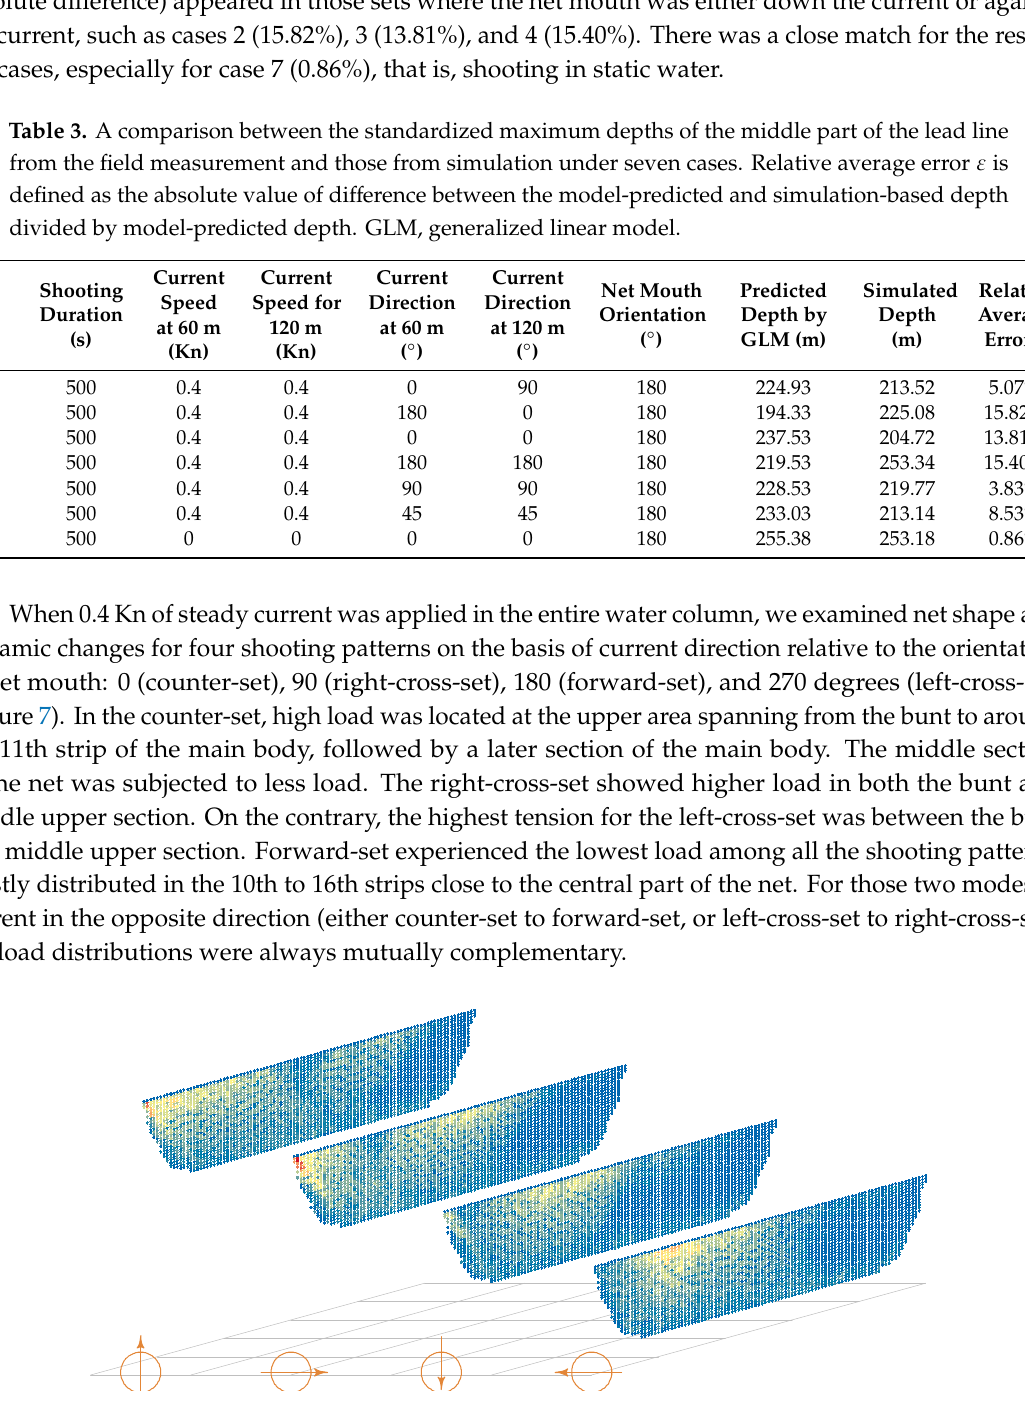
Figure 7. Load distribution (refer to color key in Figure 4) under four scenarios of current directions relative to southward net mouth at a steady current of 0.4 Kn in the entire water column, from left to right, counter-set, right-cross-set, forward-set, and left-cross-set.